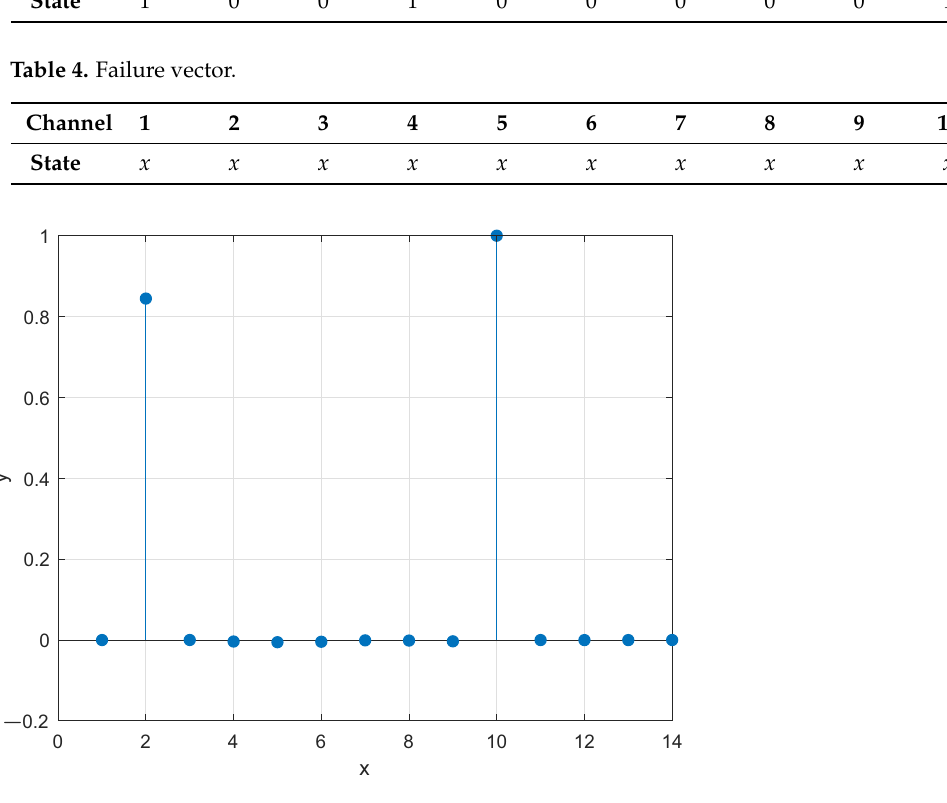
Figure 9. The response of the trained UNC to the test failure